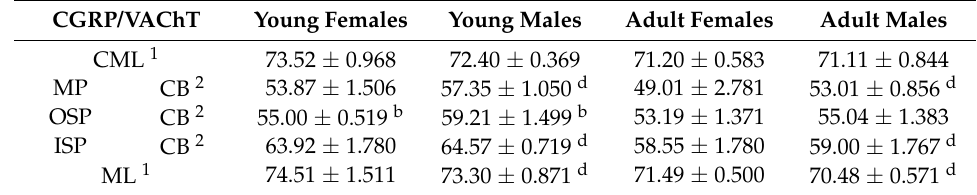
Table 3. The co-localization of CGRP with a vesicular acetylcholine transporter (VAChT) in the enteric nervous structures of the porcine descending colon under physiological conditions in young (10-week old) females and males and adult (6–8 months old) females and males. CGRP/VAChT Young Females Young Males Adult Females